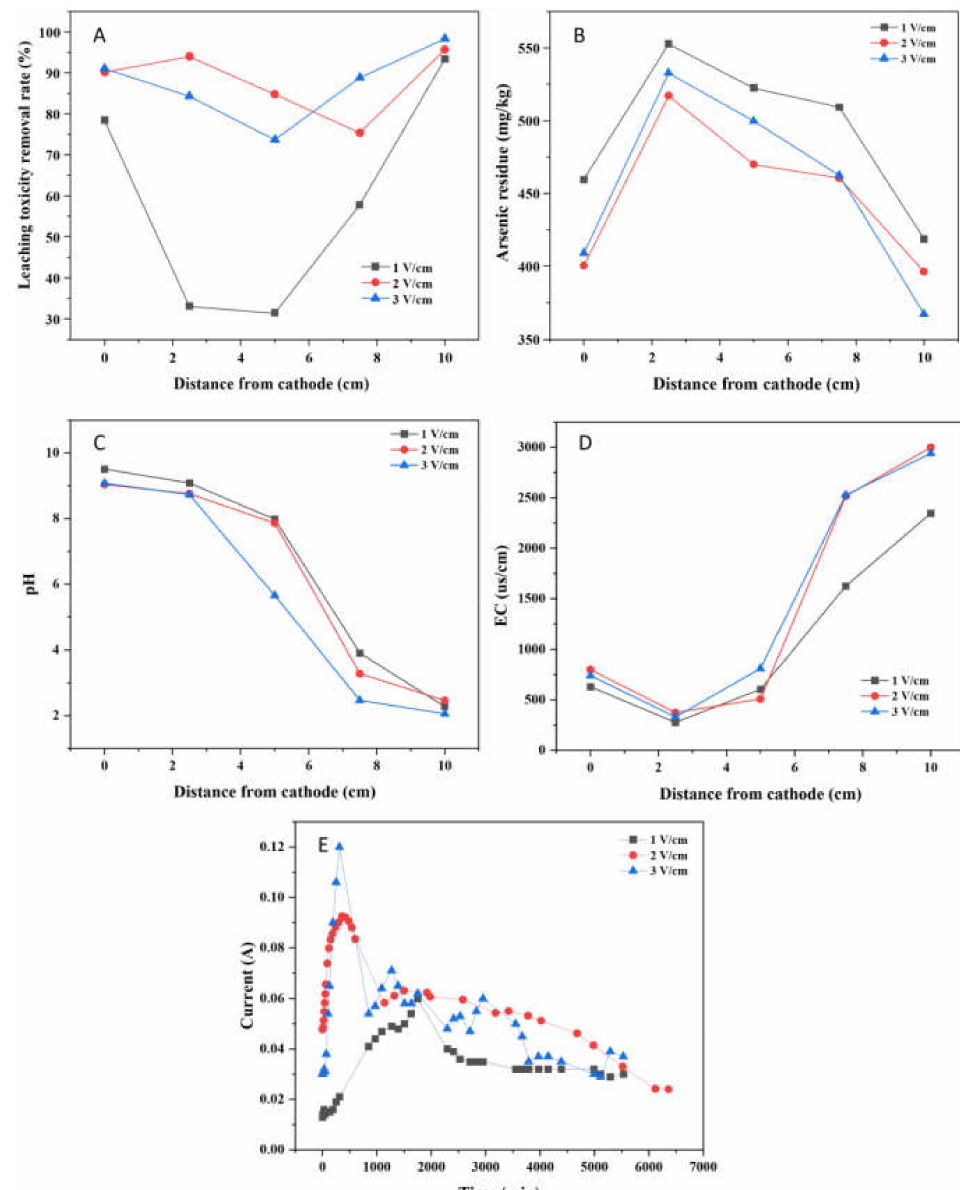
Figure 6. Effect of voltage gradient for the remediation of arsenic-contaminated soil by EK-PRB (Leaching toxicity removal rate ( A ), arsenic residue ( B ), Ph ( C ), EC ( D ) and current ( E